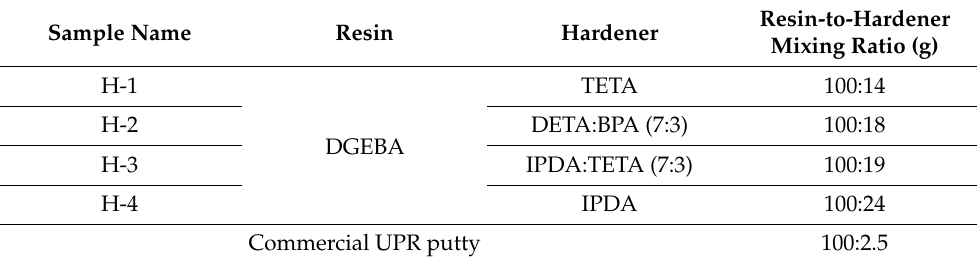
Table 2. Compositions and viscosities of the developed and commercial